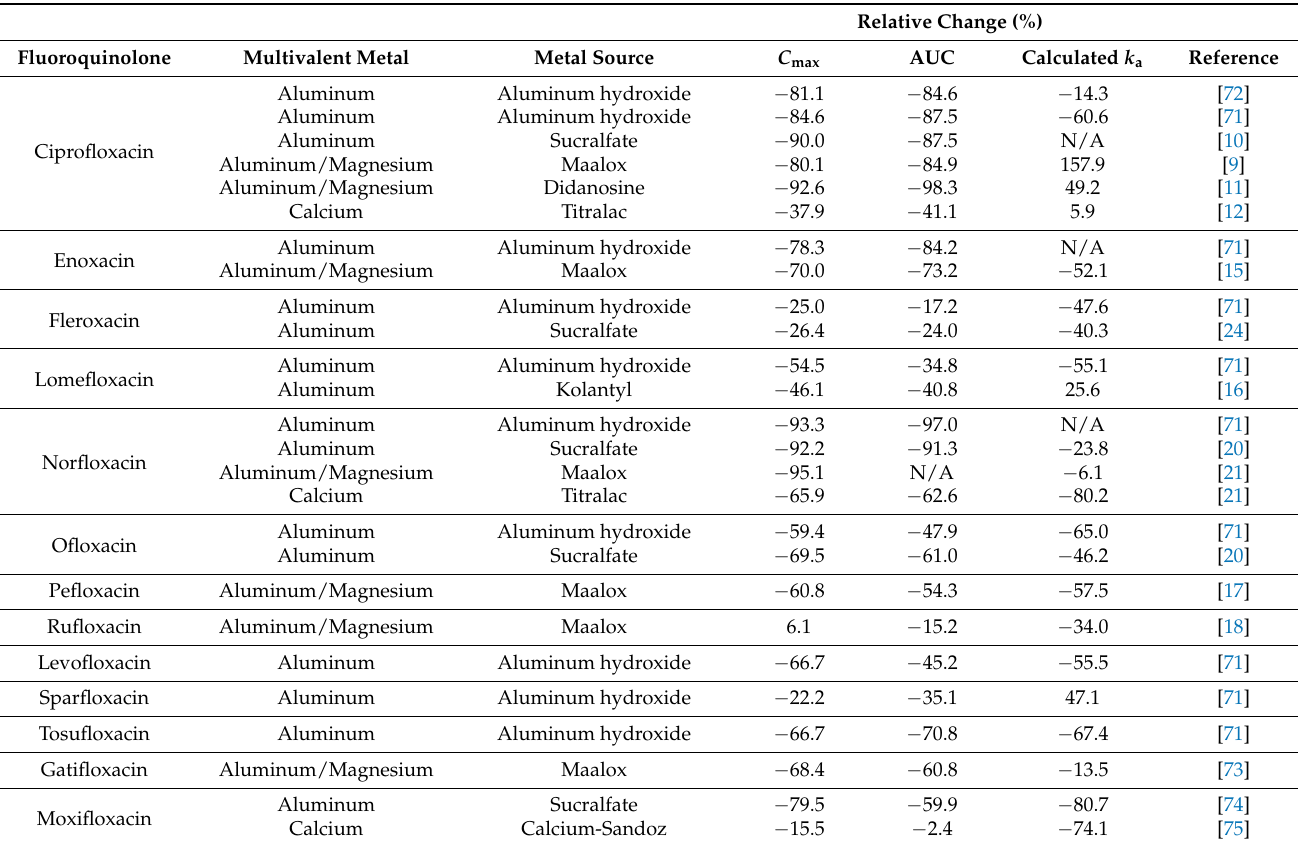
Table 2. Relative change of fluoroquinolone pharmacokinetic parameters upon coadministration with antacids and drug products containing multivalent